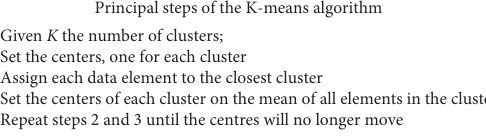
Figure 11: Steps of K-means algorithm.